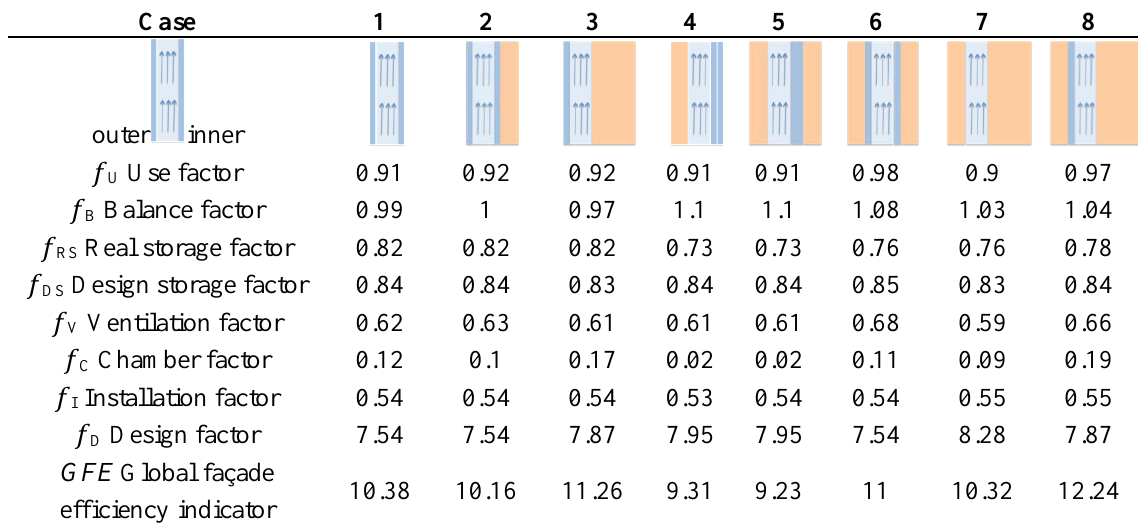
Table 3. Results obtained in different façade